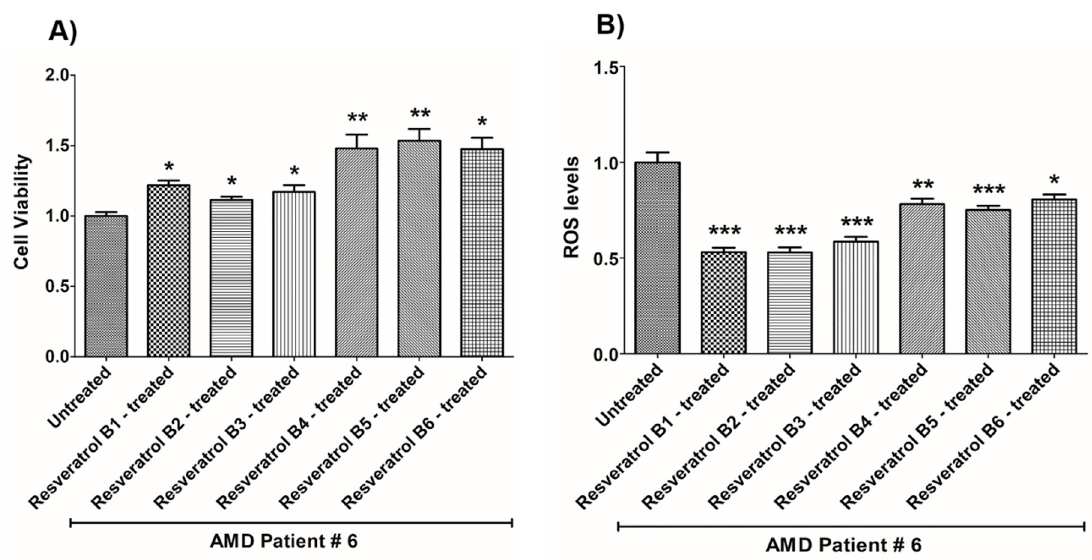
Figure 7. E ff ects of resveratrol formulations on cell viability ( A ) and ROS levels ( B ) in AMD patient #6.